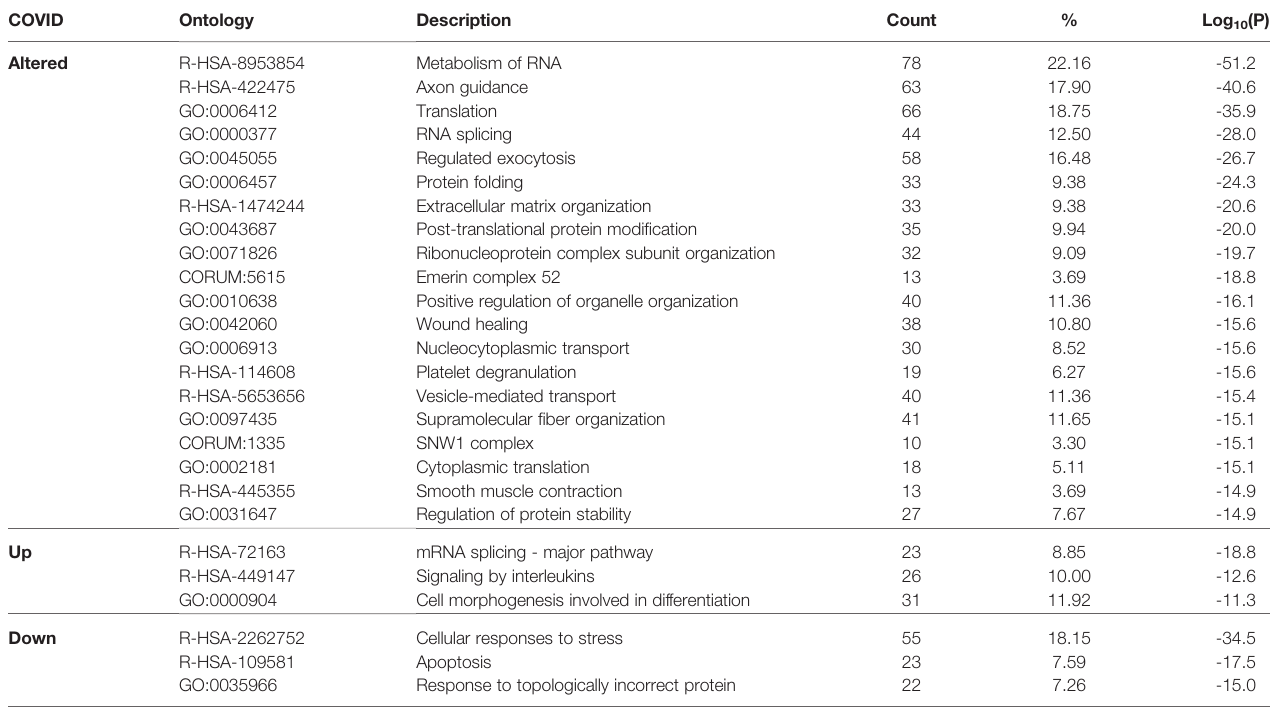
TABLE 2 | Top enriched pathways and processes related to COVID-altered proteins. COVID Ontology Description Altered R-HSA-8953854 Metabolism of